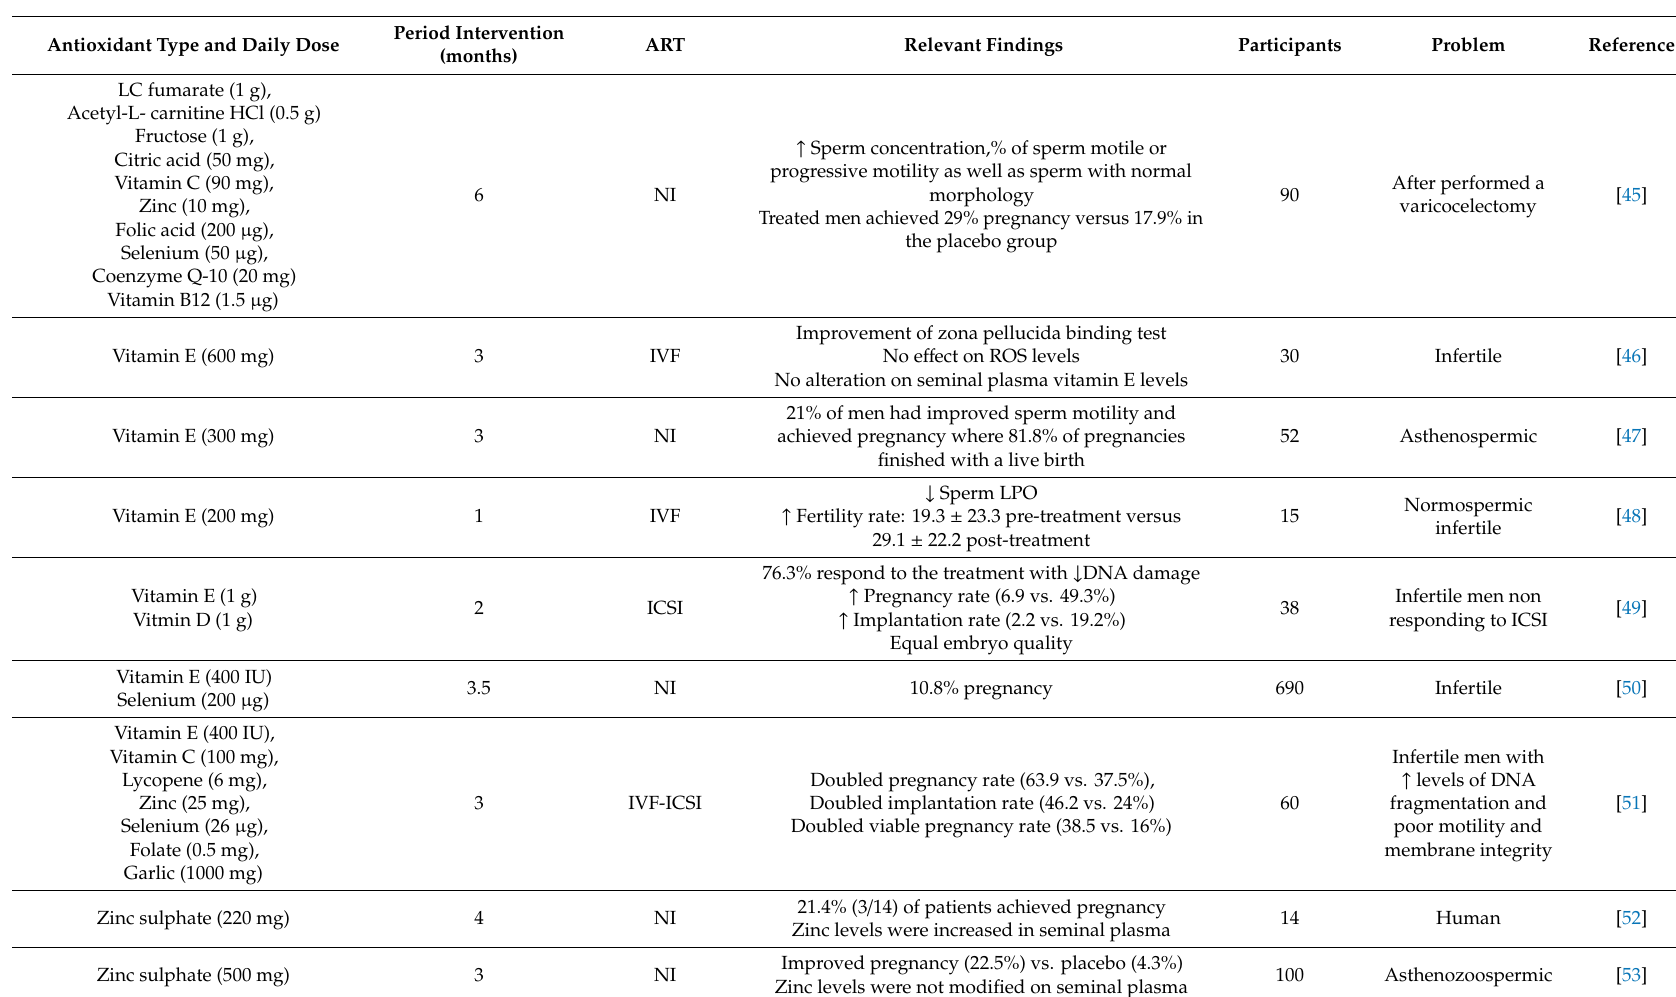
↓ Sperm LPO ↑ Fertility rate: 19.3 ± 23.3 pre-treatment